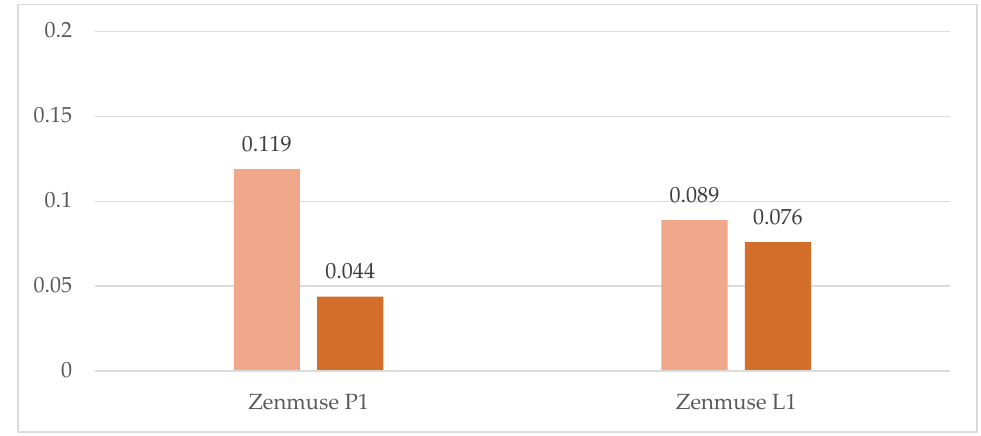
Figure 35. C2C analysis. Zenmuse P1 and L1 compared with SX10 data: standard deviation (m) in light orange; mean distance (m) in orange.